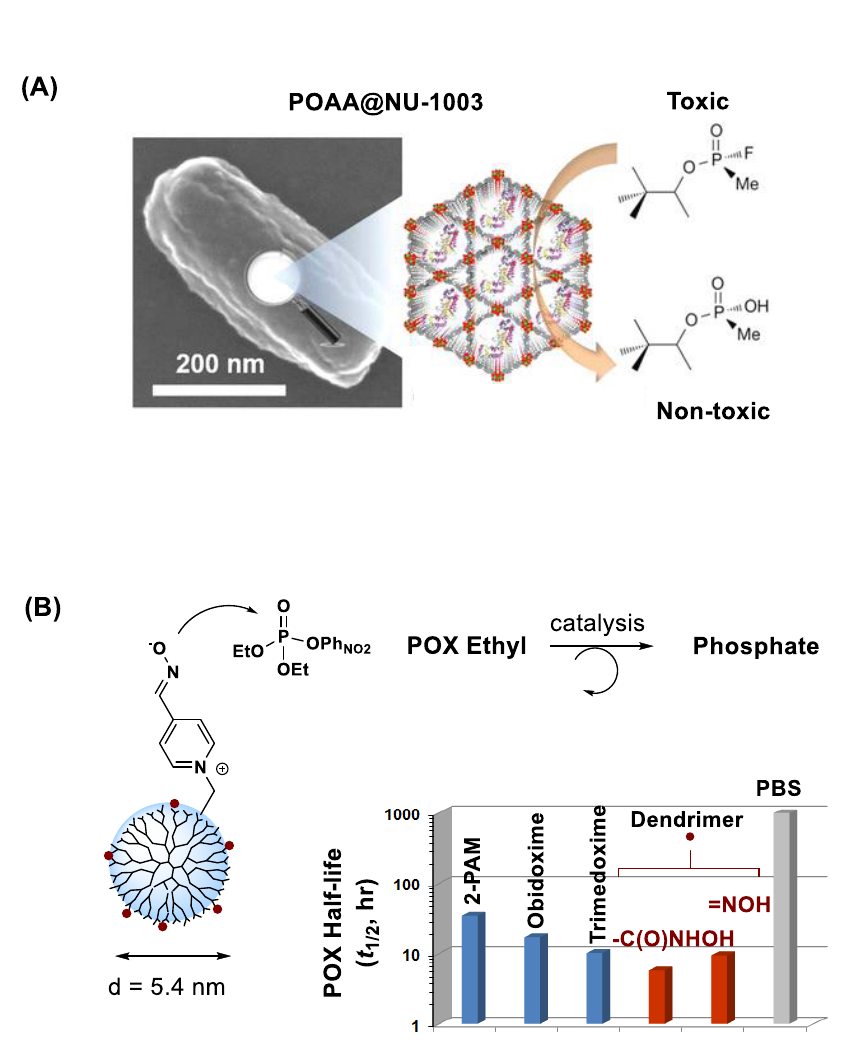
Figure 8. ( A ) Inactivation of soman (GD) by mesoporous zirconium-based metal–organic framework (MOF; NU-1003) immobilized with organophosphorus acid anhydrolase (OPAA). Reproduced with permission from [117], Copyright 2016, American Chemical Society. ( B ) POX inactivation by